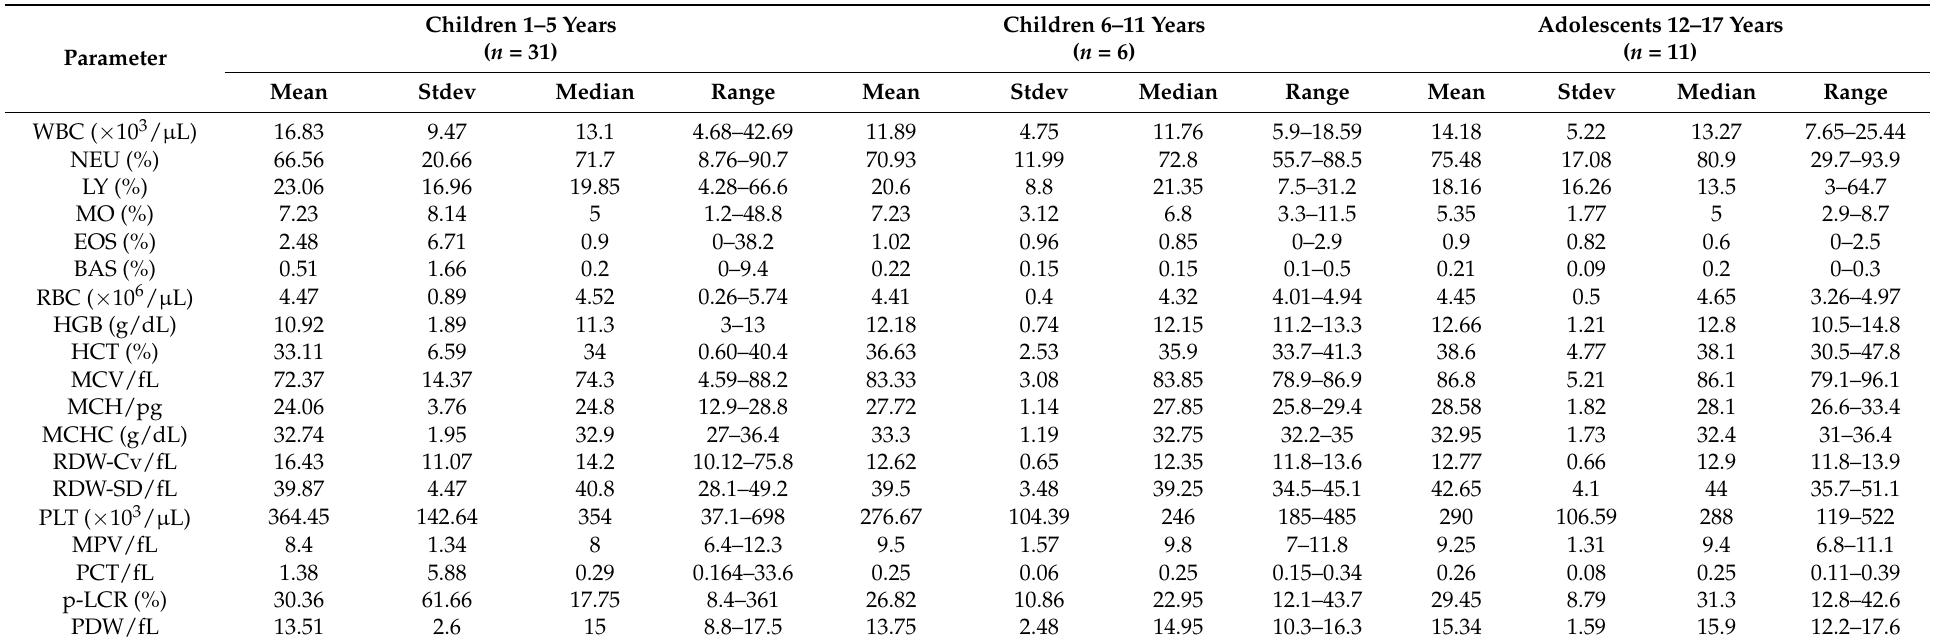
Table 2. Descriptive statistics for hematological parameters.